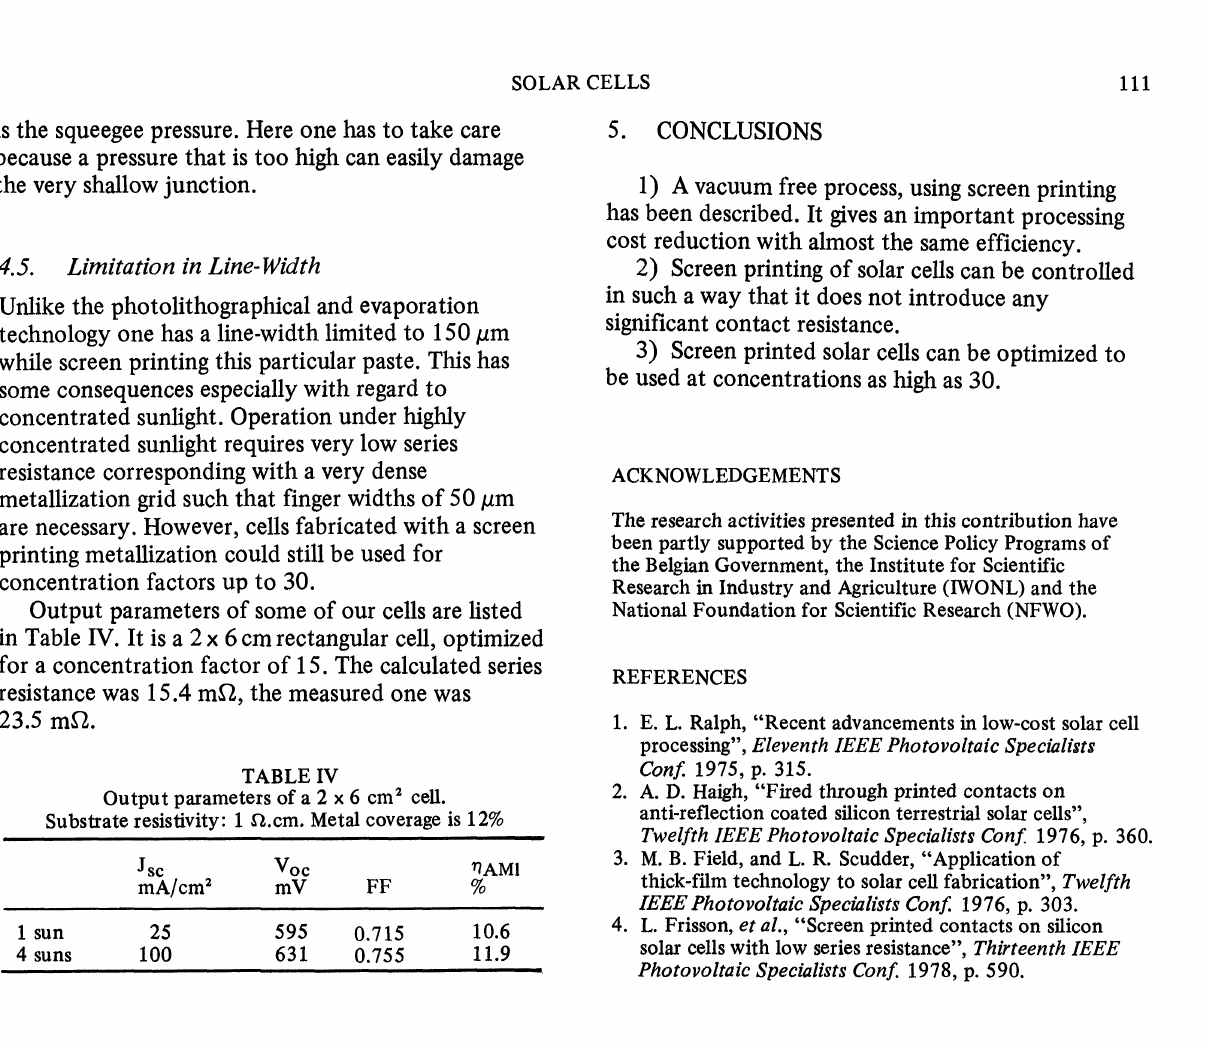
TABLE IV Output parameters of a 2 x 6 cm cell. Substrate